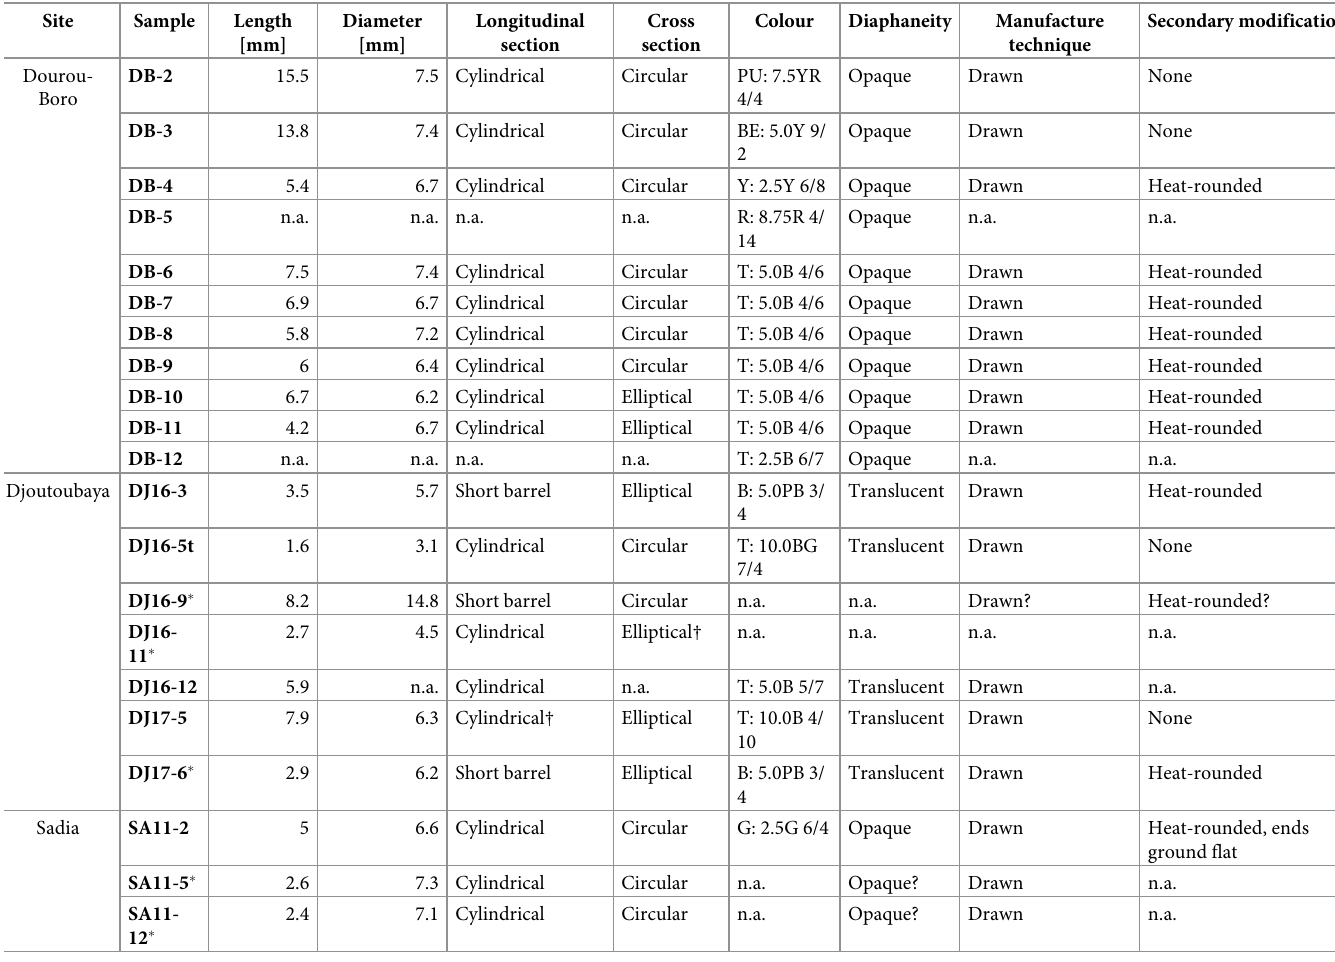
Table 1. Morphological and visual characteristics of the 21 glass beads found in Dourou-Boro and Sadia (Mali), and in Djoutoubaya (Senegal).